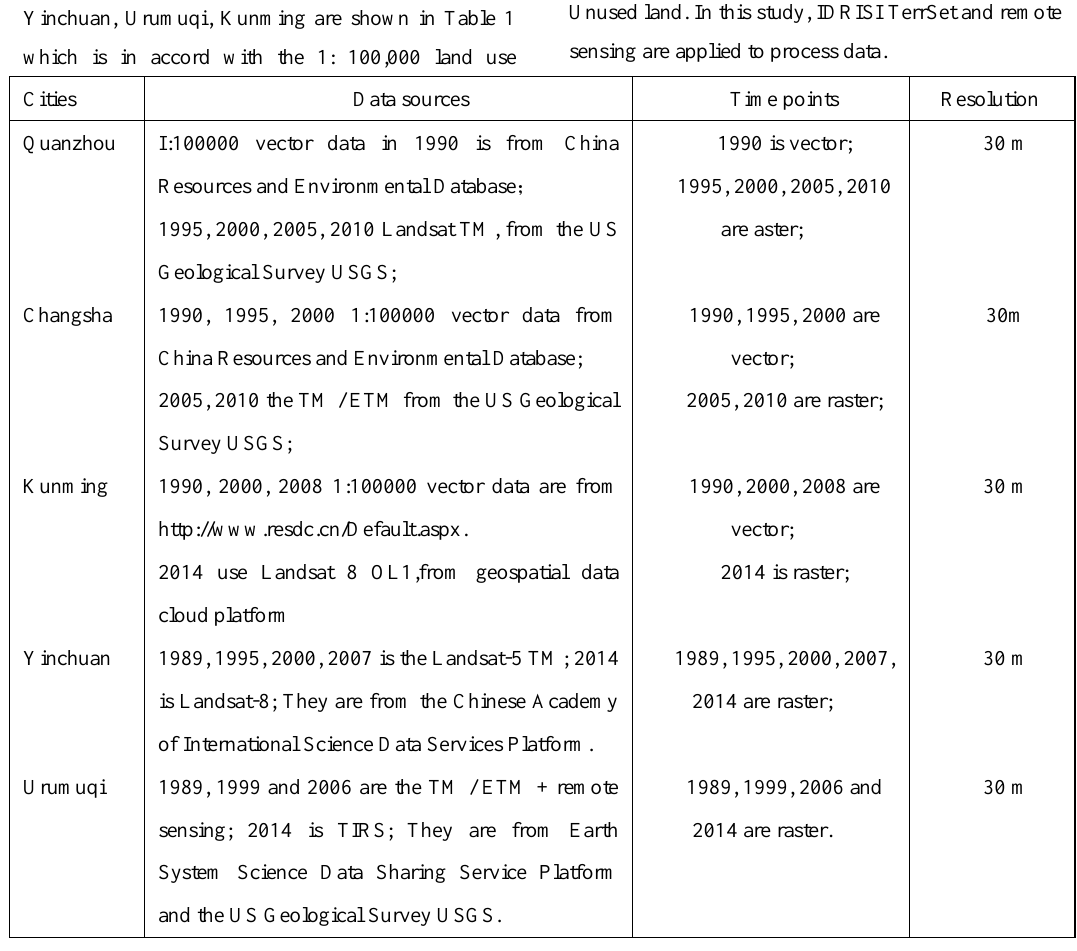
Table 1. The study area data